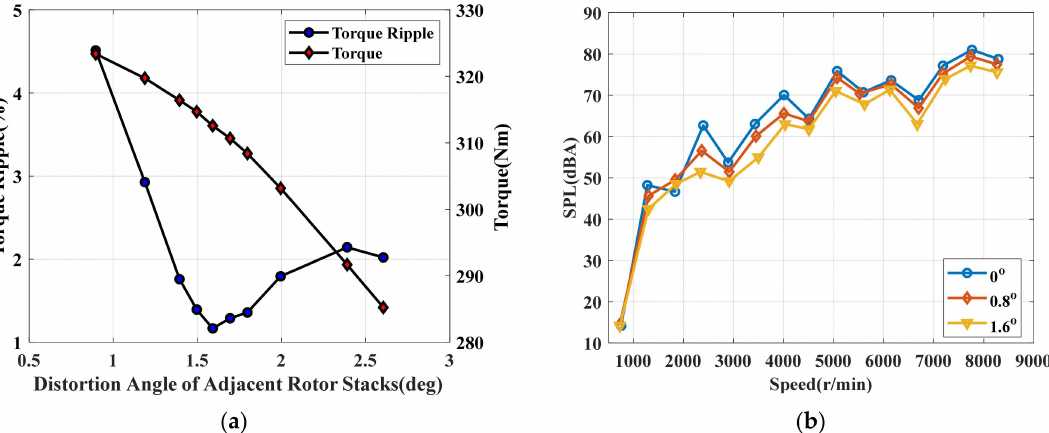
Figure 10. Optimization results of different skew angles. ( a ). Comparison of torque amplitude and torque ripple at different skew angles; ( b ) Comparison of sound pressure levels at different skew